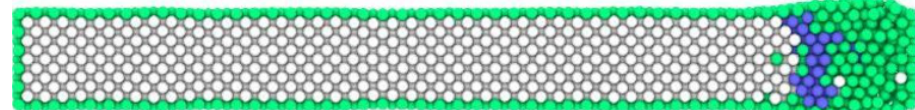
Fig. 22. Cut of the initially perfect nanorod by the plane perpendicular to the Y axis, at the time instant 10 ps after the cyclic loading start.  x 0 = 0.5 Å,  =1 THz. Green shows the surface atoms and other structureless ones; white shows the atoms forming the FCC lattice; blue shows the atoms forming the BCC lattice.